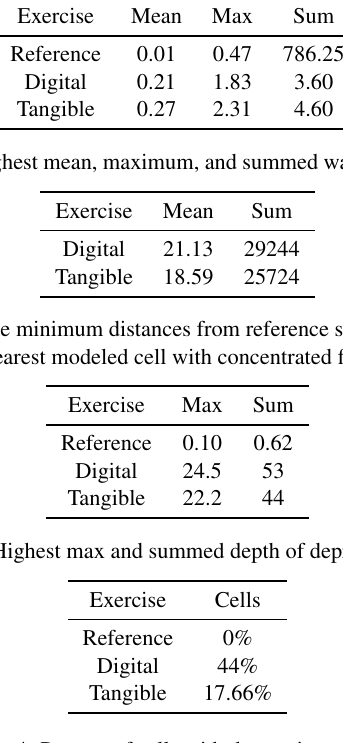
Table 4: Percent of cells with depressions (3 ft 2